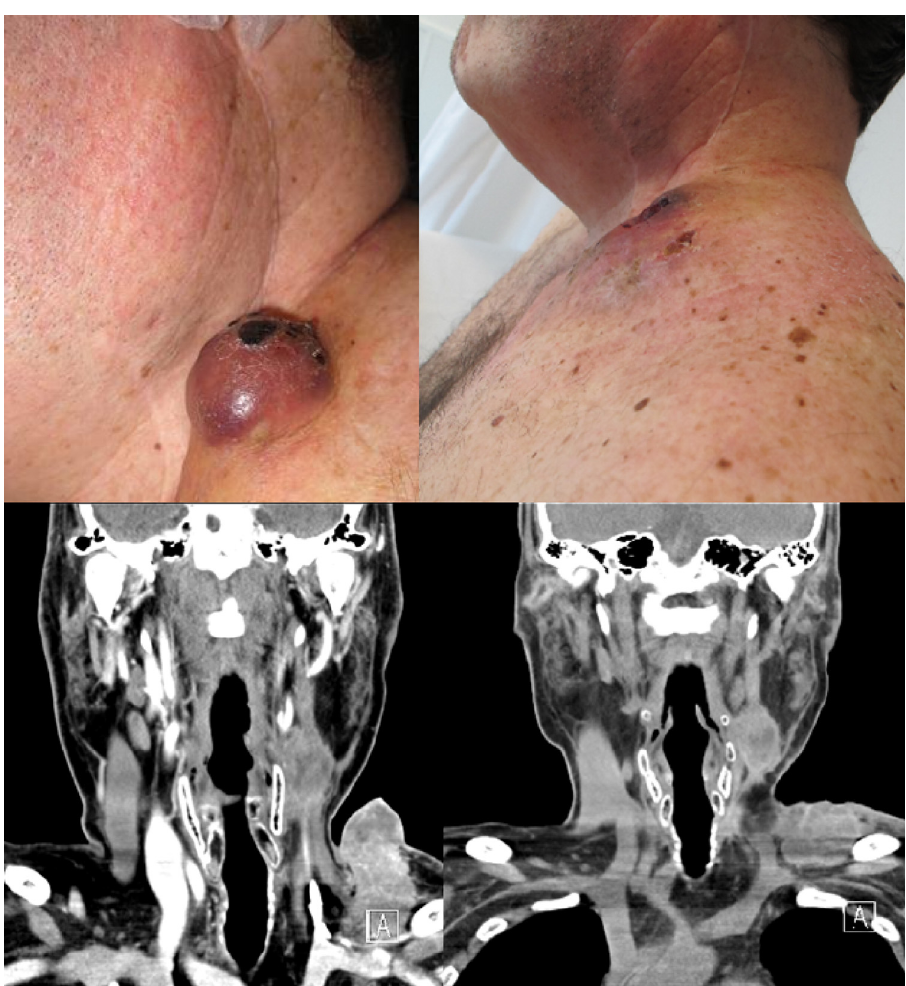
Figure 1 Case 1: External aspect and CT-scan of a lower left cervical mass prior (left images) and after four weeks (right images) of the